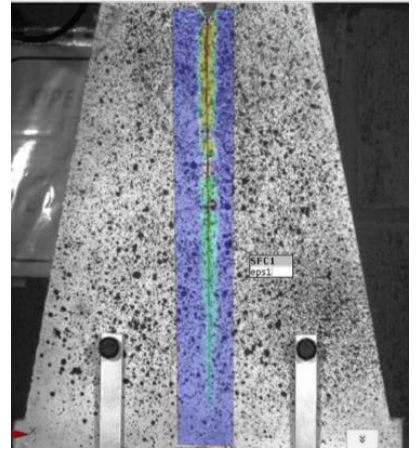
Figure 2. Representative black dot pattern, with location of the region of interest (ROI) around the interface for Digital Image Correlation.